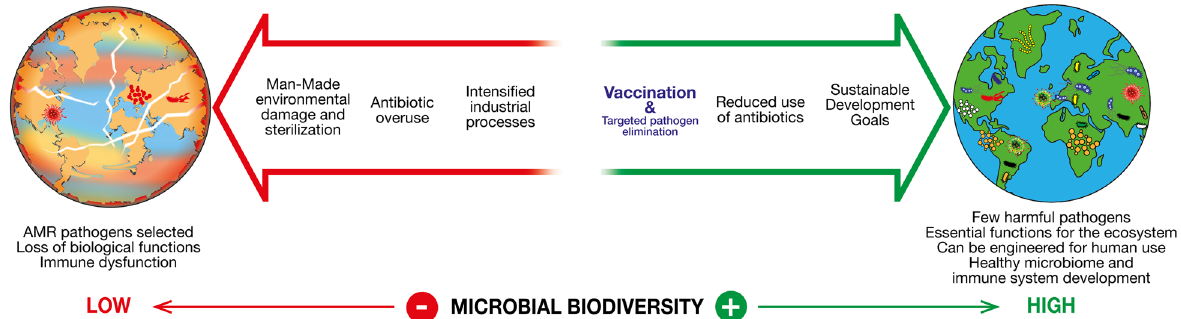
Fig. 1 Competing challenges in the preservation of global microbial